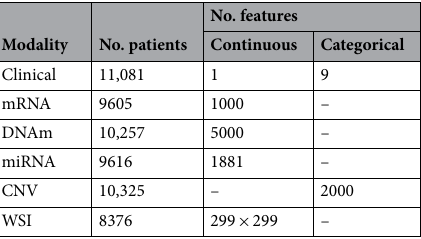
Table 3. Summary information of the different data modalities after